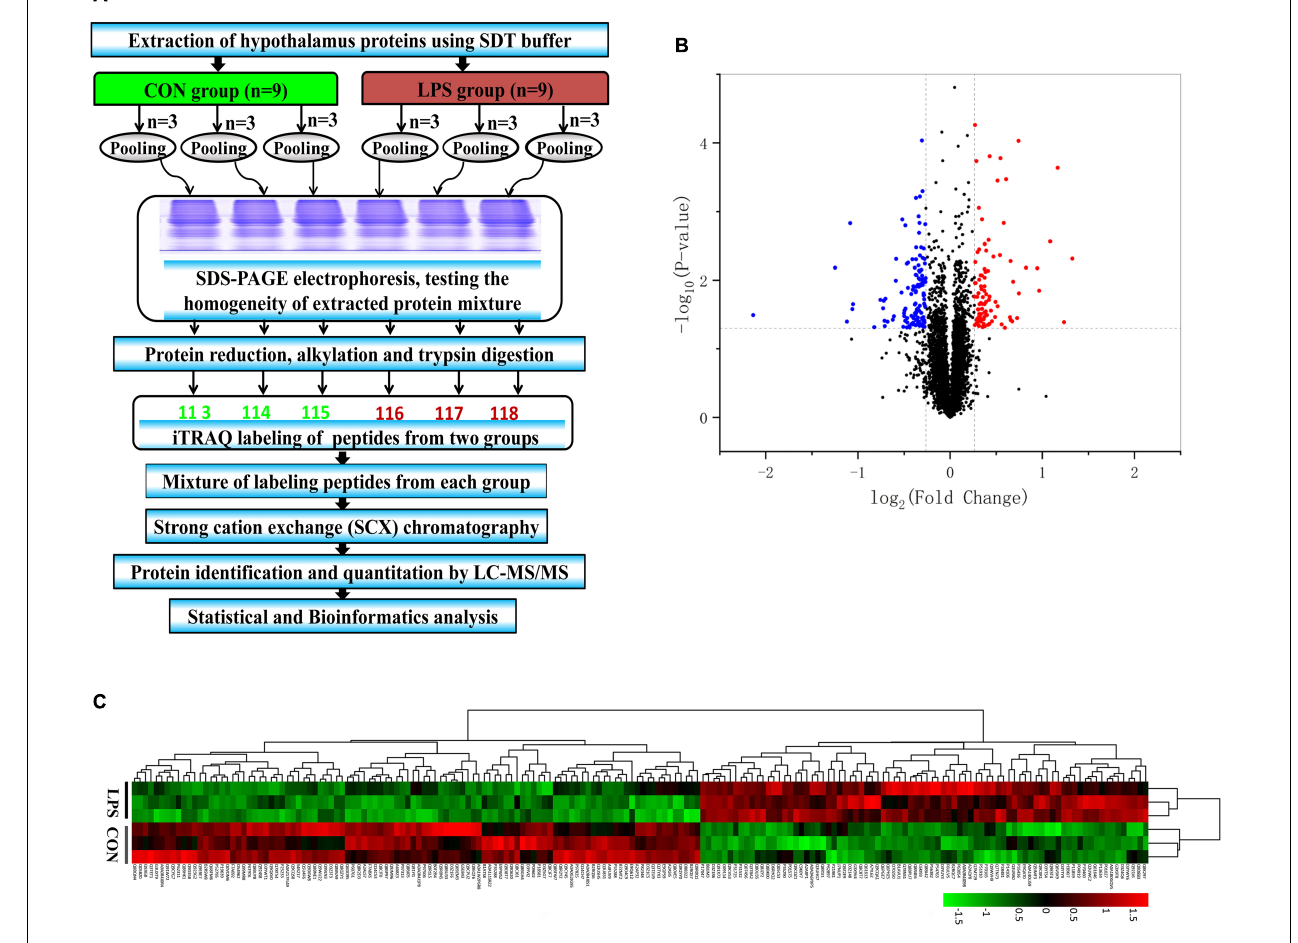
FIGURE 2 | iTRAQ-based proteomic analysis of hypothalamus samples from LPS mice and controls. (A) Workflow diagram. The proteins were subjected to iTRAQ labeling followed by mass spectrometric analysis. (B) Volcano plot of all 4787 identified proteins quantified by proteomic analysis from the LPS and CON groups, respectively. One hundred eighty-seven proteins with at least 1.20-fold changes at P < 0.05 relative to the controls were identified in the two groups. Non-significantly changed, significantly downregulated, and upregulated proteins are shown in black, blue, and red, respectively. (C) Heatmap of the 187 different proteins in the comparing the LPS and CON groups. The heatmap was plotted based on the levels of the differential proteins. The heatmap data was normalized using Z-scores . Distinct separation was observed between control and LPS-depressed mice. Rows: Samples; Columns: proteins. The color intensity indicates the protein expressional level as displayed: red, highest; green,